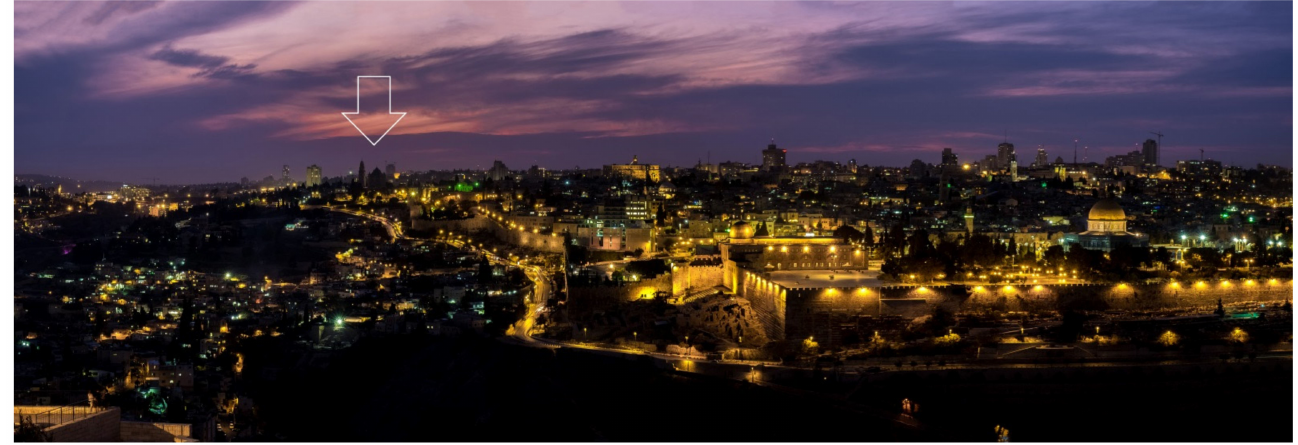
Figure 9. Distant, exemplary east observation direction (K3) at night, photo: Oliwia